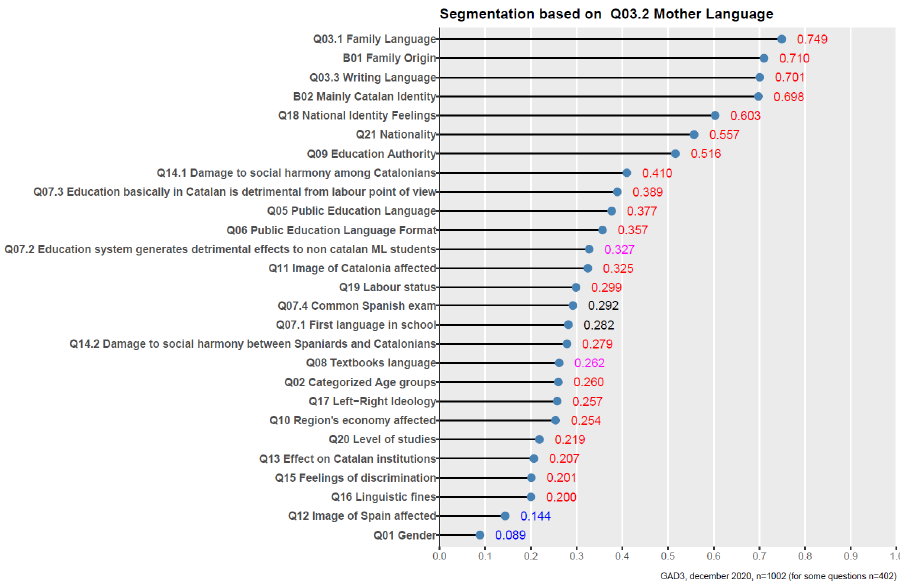
Figure 2. Differences among Catalonians depending on the “ mother language” segmentation in Table 3. The variables are sorted by their C values. The different colours of the figures correspond to p ‐ values that are less than 0.001 (red), between 0.001 and 0.01 (magenta), between 0.01 and 0.05 (black), or just over 0.05 (blue).